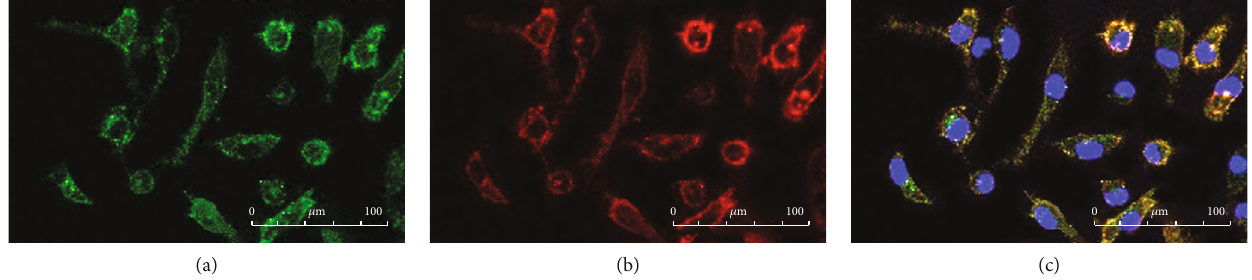
Figure 2: Immuno fl uorescence of TLR4 and CD14 in the ANA+ group after LPS stimulation. (a) Monocytes were identi fi ed by CD14. Some cells changed from round to fusiform. (b) TLR4 was mainly expressed in the cell membrane. (c) With LPS stimulation, the mononuclear cells coexpressed TLR4 and CD14.